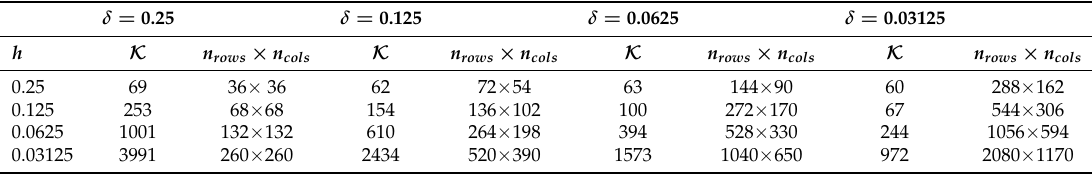
Table 3. The condition number K (rounded to the nearest integer) and the dimensions n rows × n cols of the discretization matrix ( Q ⊗ A + L ⊗ B ) for α = 0.75 as a function of the space step h and the time step δ . δ = 0.25